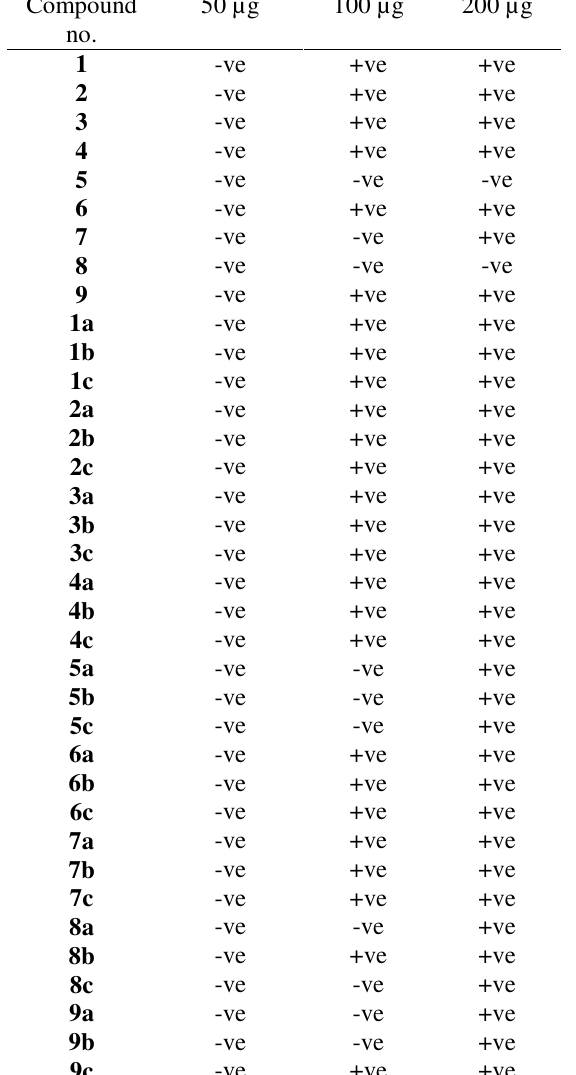
Table 2 . Antibacterial activity of